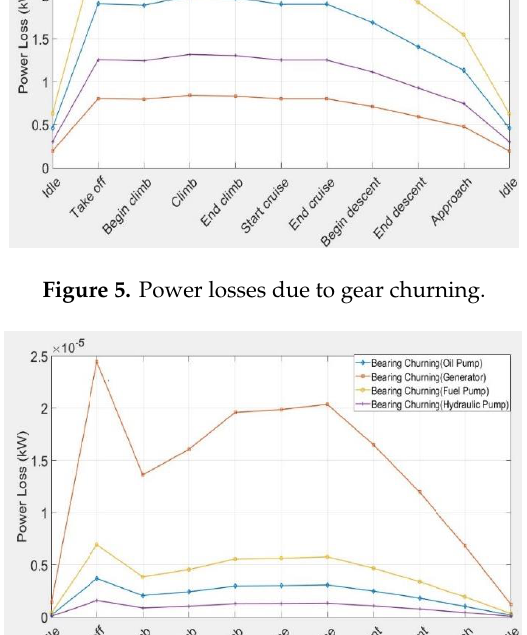
Figure 5. Power losses due to gear churning.